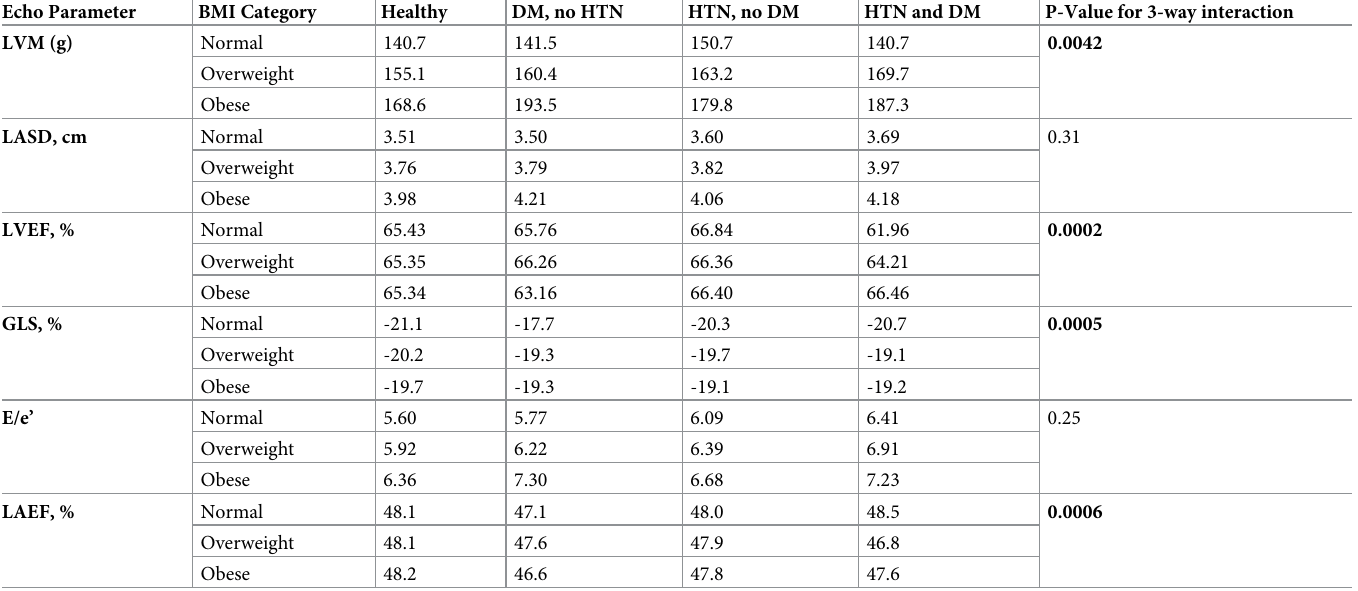
Table 3. Least square means of echocardiographic traits by BMI category, hypertension status, and diabetes status (modeled jointly), adjusted for age, sex, and cohort. Echo Parameter